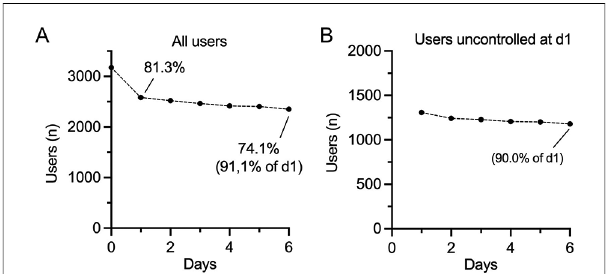
FIGURE 1 User numbers during baseline HBPM interval. ( A ) Number of users with self-reported diagnosis of hypertension who started the fi rst HBPM interval ( n =3175). Percentages are given in brackets. ( B ) Number of users with a self-reported diagnosis of hypertension who have started a fi rst HBPM interval and are uncontrolled on the fi rst day of measurement ( n =1309). Percentages for day 2 and 6 are given in brackets.